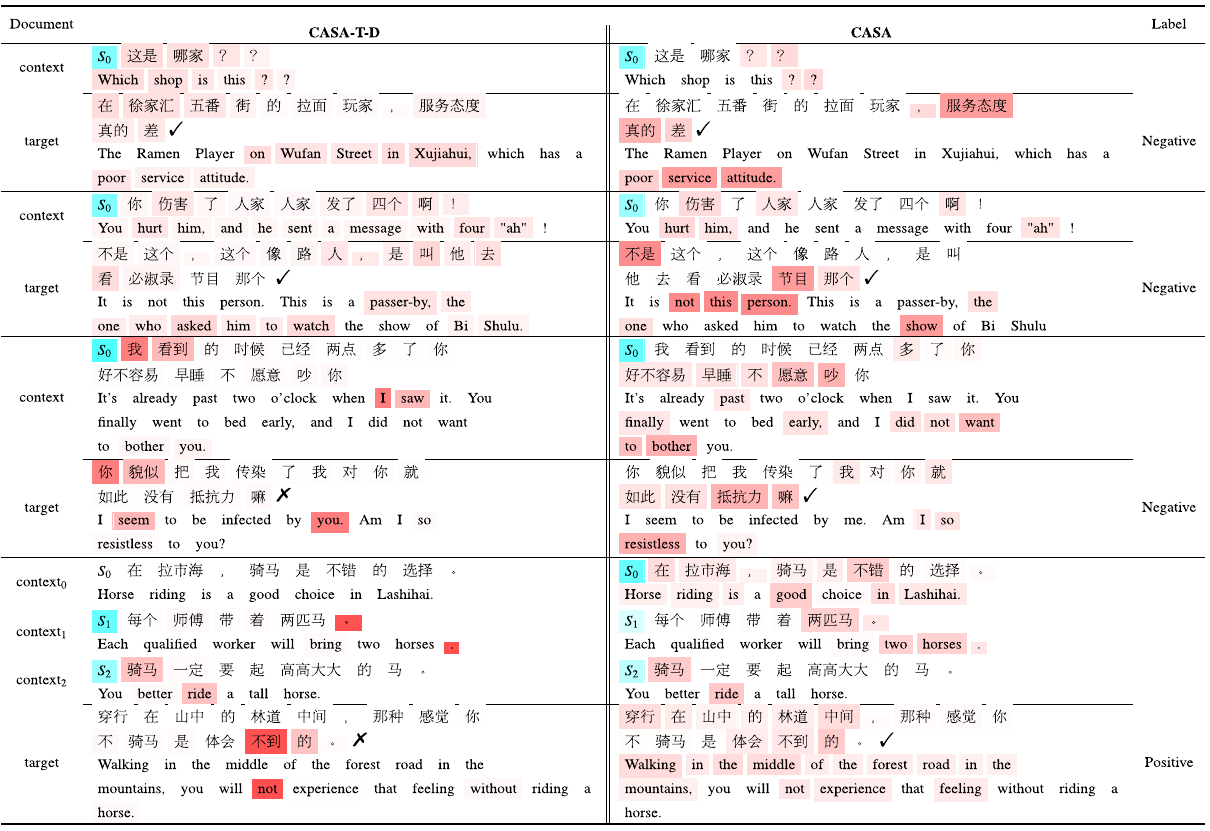
Table 5. Case study. Visualization of attention weight distribution from CASA-T-D and CASA on testing examples. For CASA, the source domain is Virus. Marker (cid:31) signifies correct prediction, while marker × signifies incorrect prediction. Blue denotes the sentence weight, and red denotes the word